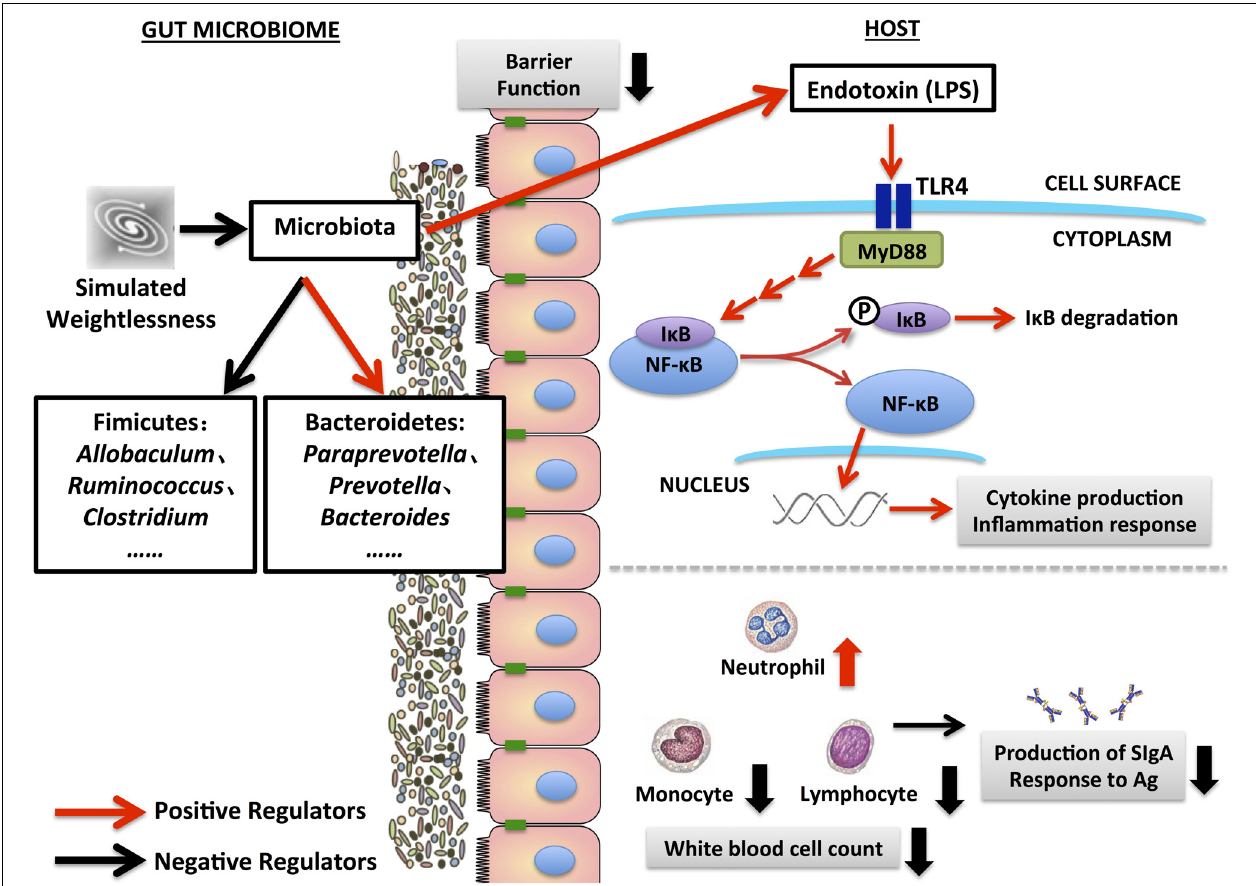
FIGURE 8 | Schematic diagram for the disruption of intestinal mucosal barrier functions induced by simulated